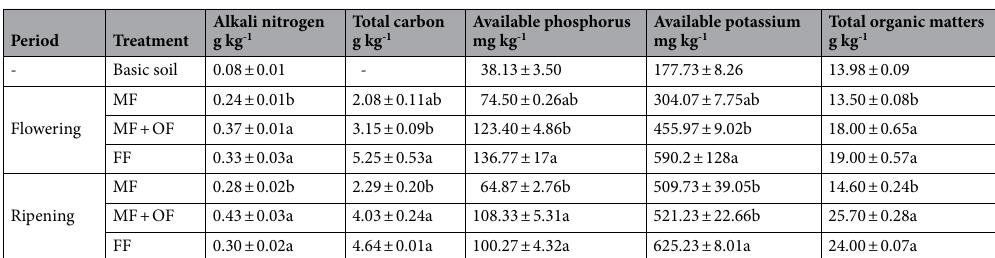
Table 3. Effects of different fertilization treatments on soil nutrients of kiwifruit culture. The different letters after the values indicated the significant differences (P < 0.05) of soil nutrients between the treatments. The standard errors (n = 9) are